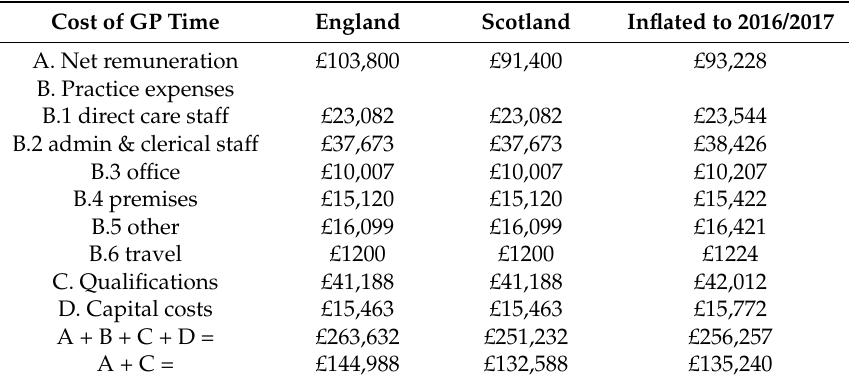
Table A1. Annual GP costs 2015/2016 [34,36].